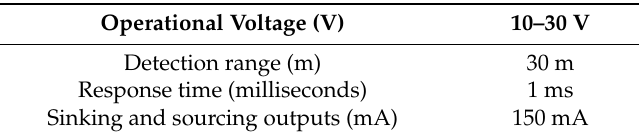
Table 1. IR light-beam sensor